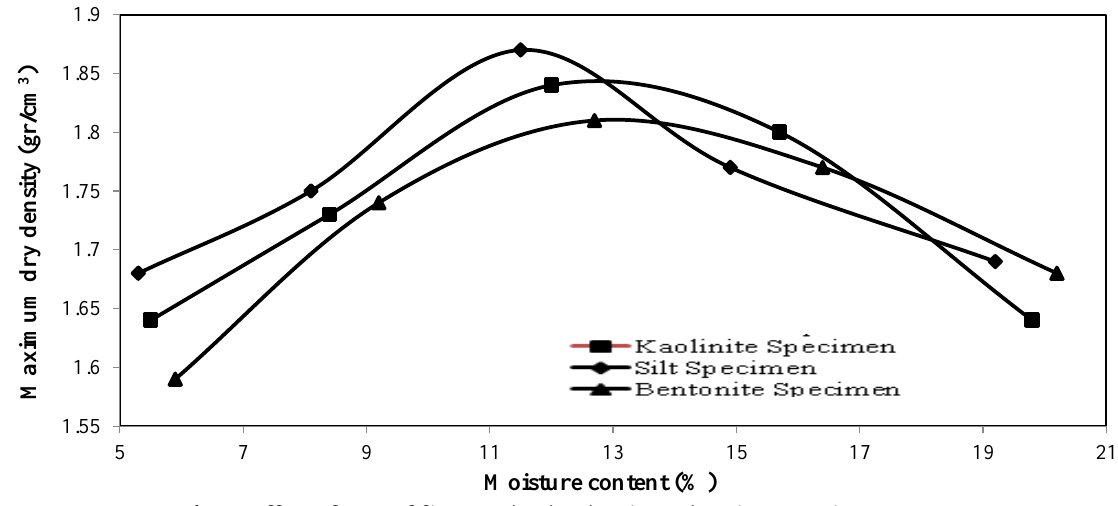
Fig. 5. Effect of type of fines on the dry density and optimum moisture